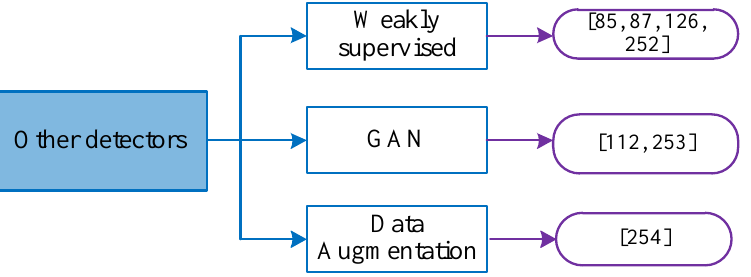
Figure 14. The other SAR ship detectors.